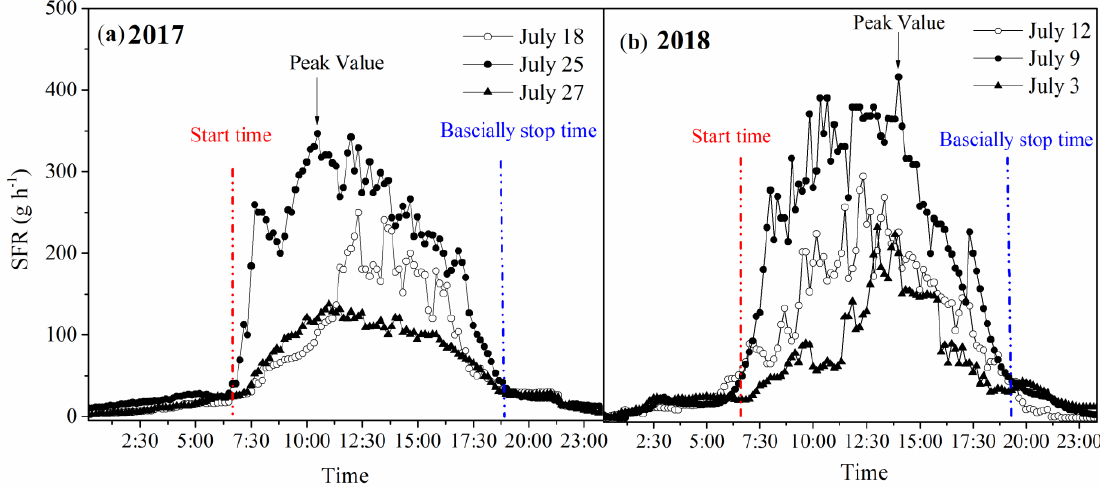
Figure 7. Daily changes in grapevine sap flow rate (SFR) under different weather conditions during 2017 ( a ) and 2018 ( b ) experimental the 2017 ( a ) and 2018 ( b ) experimental periods.